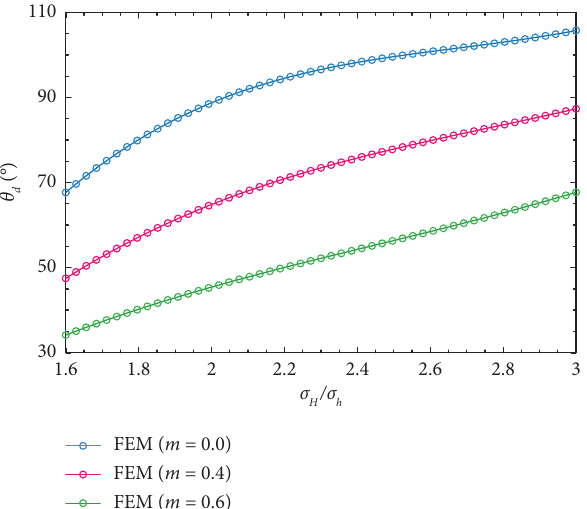
Figure 15: Final breakout width versus in situ stress ratio for diferent